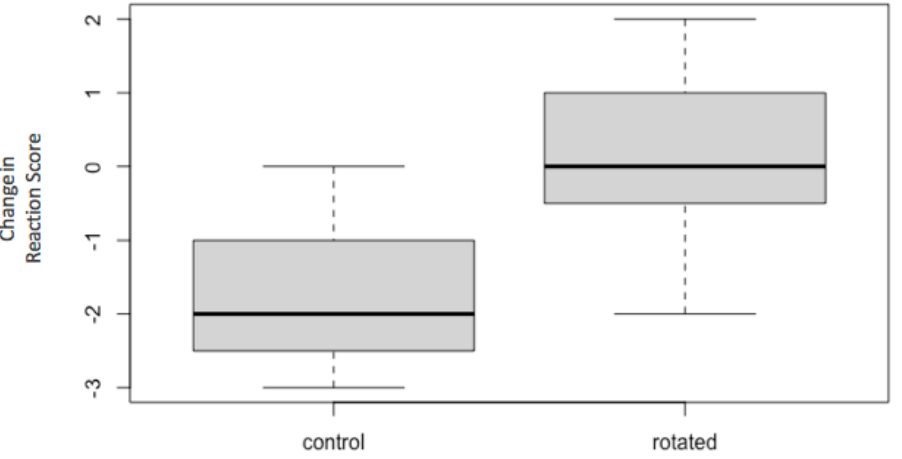
Figure 2. Boxplot of differences in Reaction Score for pass 1 by the novel object to pass 1 by the rotated object. The Control group mean (bold line) showed a decrease in reaction. The Rotated group mean showed no change in reaction. There was a significant difference between the means of the two groups.